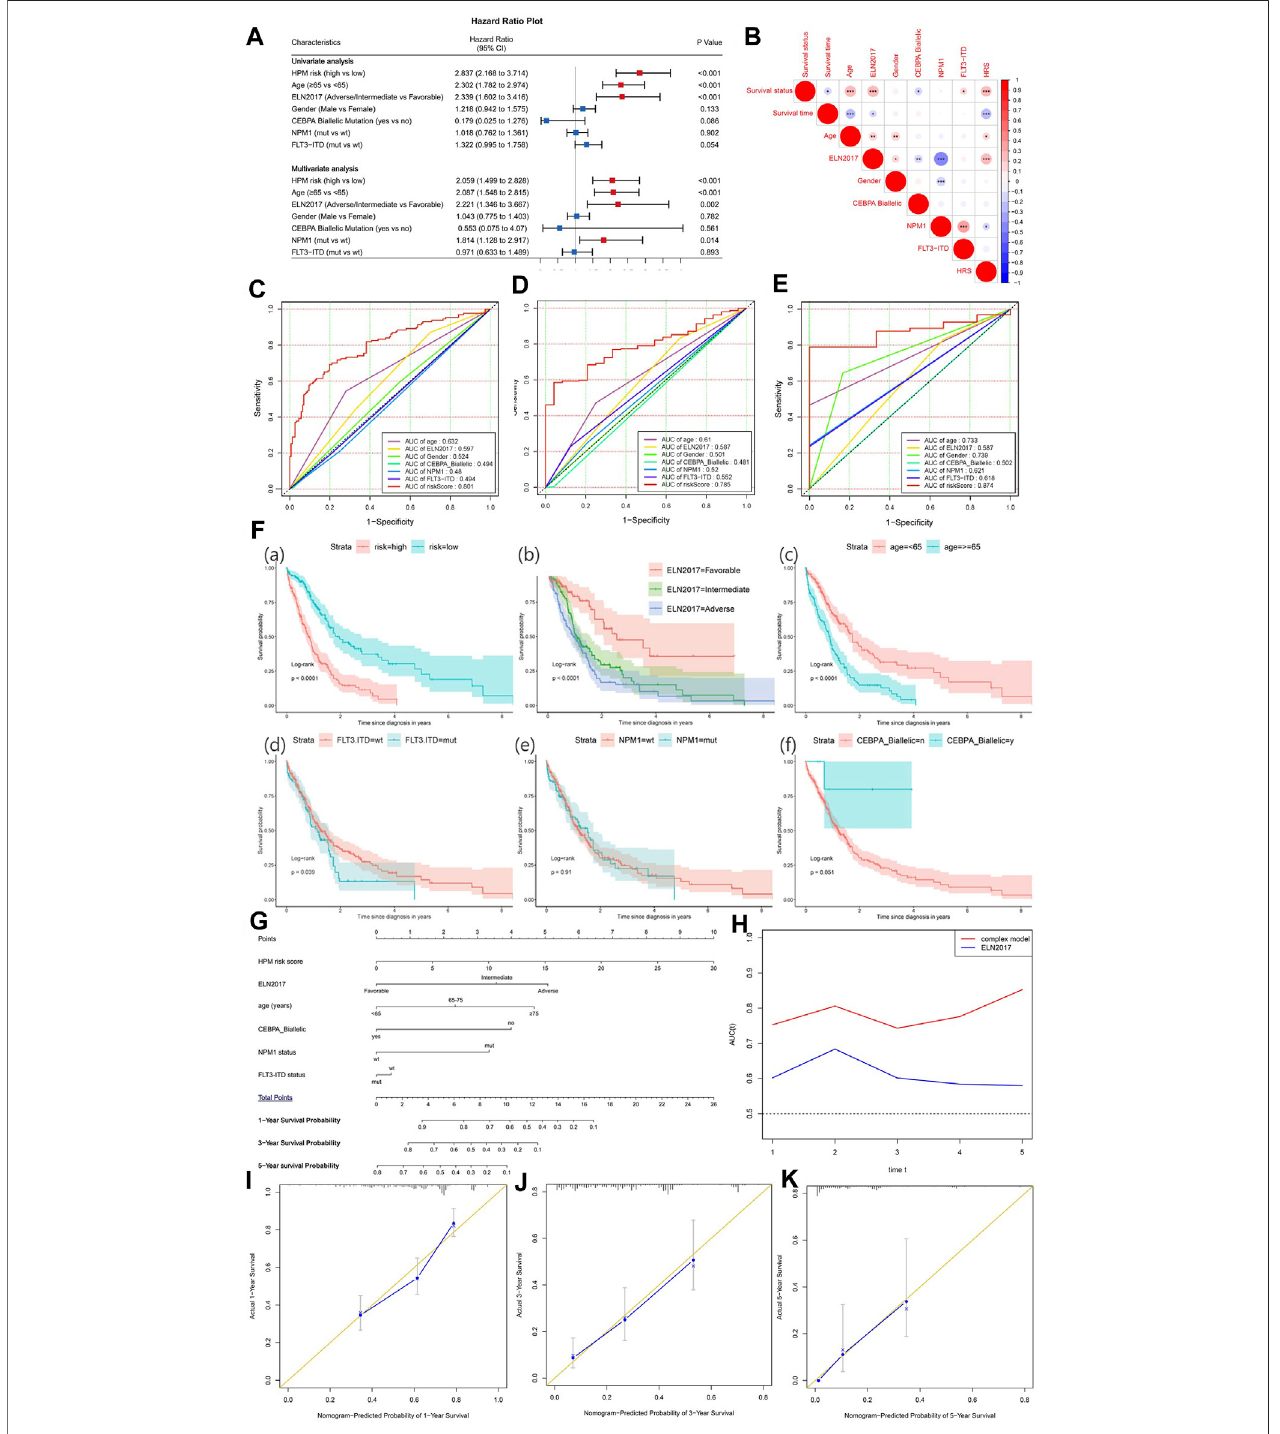
FIGURE 8 | The establishment of a nomogram to predict the overall survival of acute myeloid leukemia (AML) patients. (A) Forest plot of univariate and multivariate Cox regression analysis of clinical characteristics in AML patients. The red dot with bar indicates statistical signi fi cance ( p < 0.05). (B) Pearson ’ s correlation between hypoxia-related prognosis model (HPM) and different clinical characteristics (* p -values < 0.05; ** p -values < 0.01; *** p -values < 0.001). Receiver operating characteristic (ROC) plot of HRM and important clinical characteristics at 1 (C) , 3 (D) , and 5 years (E) . (F) Survival analysis for HPM risk and other prognostic factors in AML. (G) Nomogramofthecomplexmodelforoverallsurvivalat1,3,and5 yearsinAMLpatients. (H) Time-dependentROCcurvesforcomplexmodelandELN2017.Calibration plot at 1 (I) , 3 (J) , and 5 years (K) for validation of prognostic nomogram.